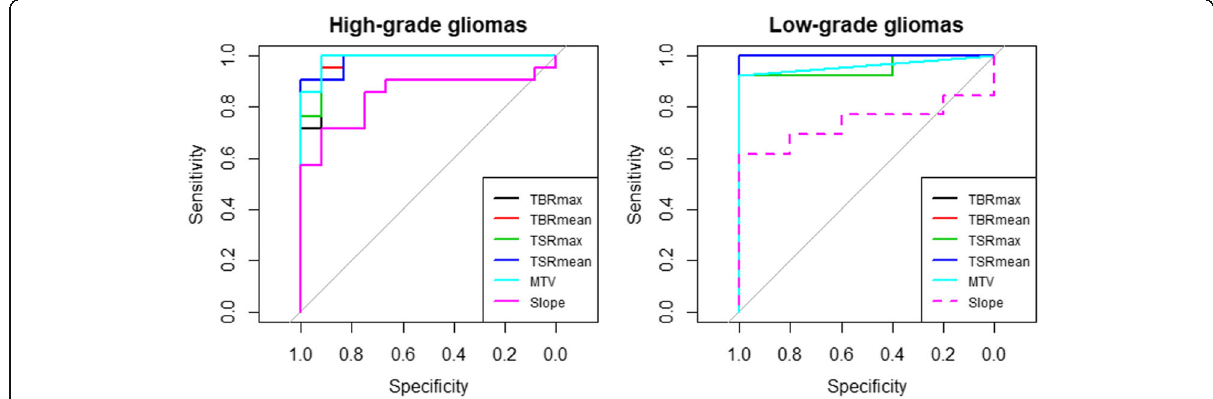
Fig. 1 Receiver operating characteristic (ROC) curves for TBR max , TBR mean , TSR max , TSR mean , MTV, and slope parameters for differentiating between recurrent or progressive gliomas and treatment-related changes in high-grade gliomas ( n = 33, left panel) and in low-grade gliomas ( n = 18, right panel). Significant ROC curves are represented in solid